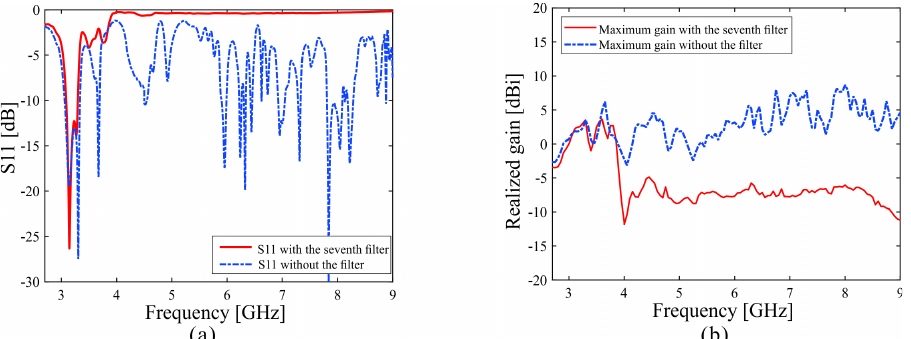
Figure 6. Comparative analysis with and without filter: ( a ) simulated S11 and ( b ) simulated maximum